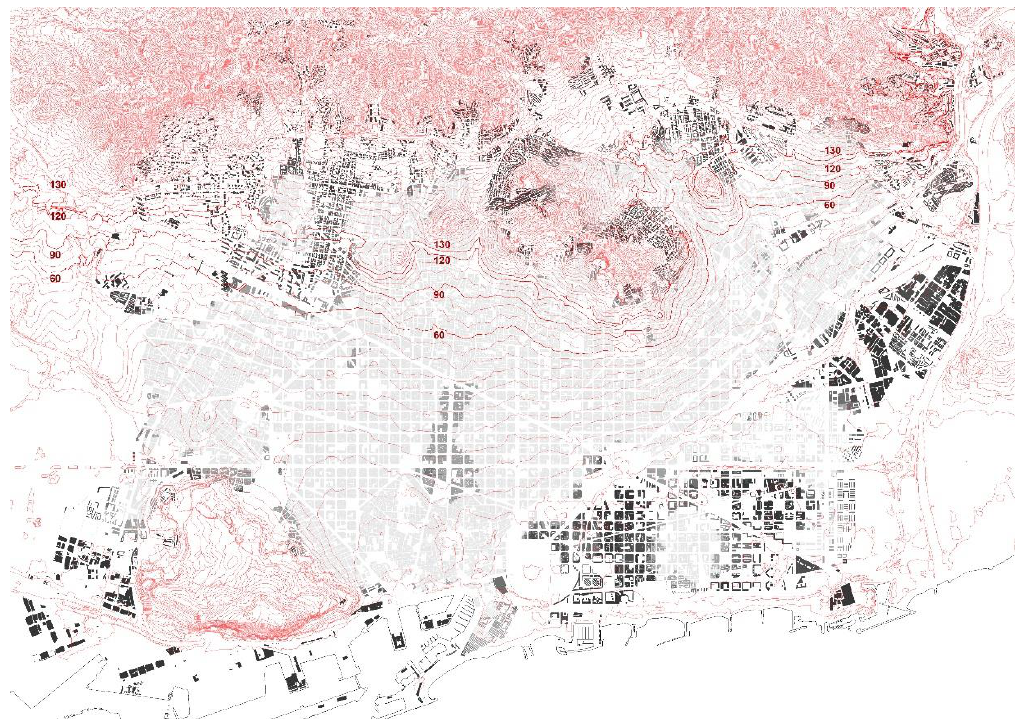
Figure 7. Areas with the fewest number of essential services (excluding facilities). Overlap of the lowest quintile of each of the categories resulting from Figure 6. Three categories are represented here with three different intensities: in black, areas in which the minimum intensity coincides in four of the services; in dark gray, in three of the services; in light gray, in two of them. The topography is superimposed in red and the urban background fabric in light gray. Table A2 in the Appendix A of this document gives a detailed explanation with precise place names for knowledgeable readers of the city.